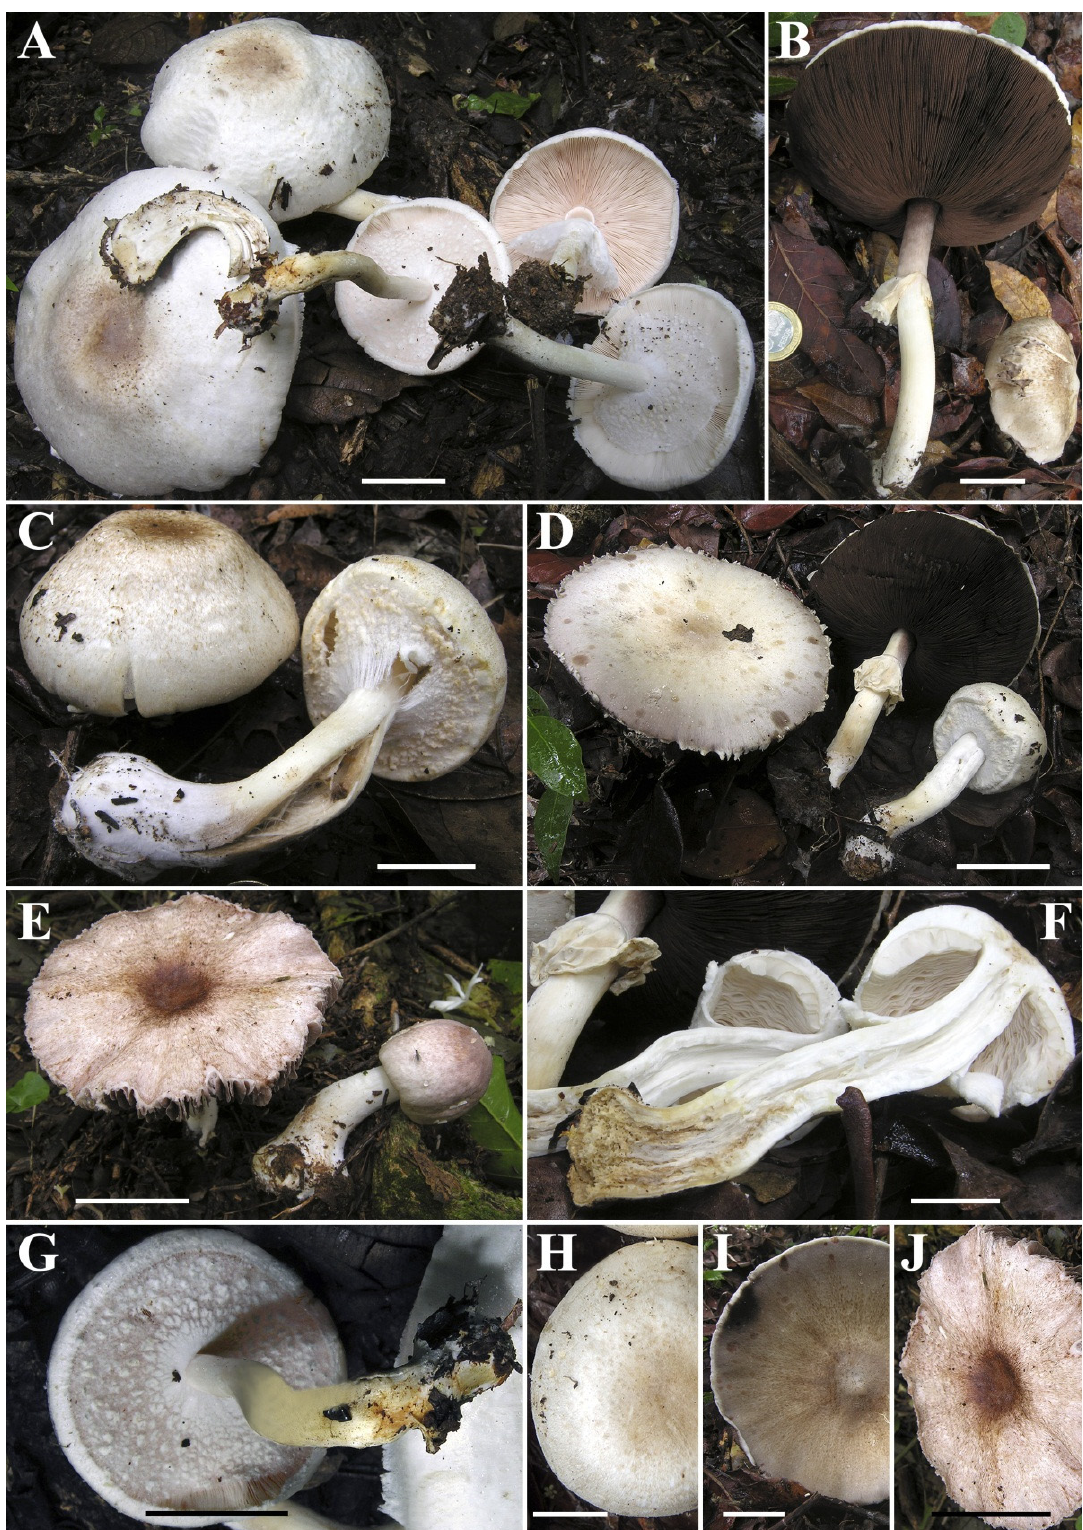
Figure 5. Macroscopic characters of Agaricus macrochlamys from the Dominican Republic. ( A – J ) Basidiomata. ( A , G ) JBSD126480; ( B , I ) JBSD126482; ( C , H ) JBSD126483; ( D , F ) JBSD126484; ( E , J ) JBSD130773. Bar = 2 cm. Photos by C. Angelini.